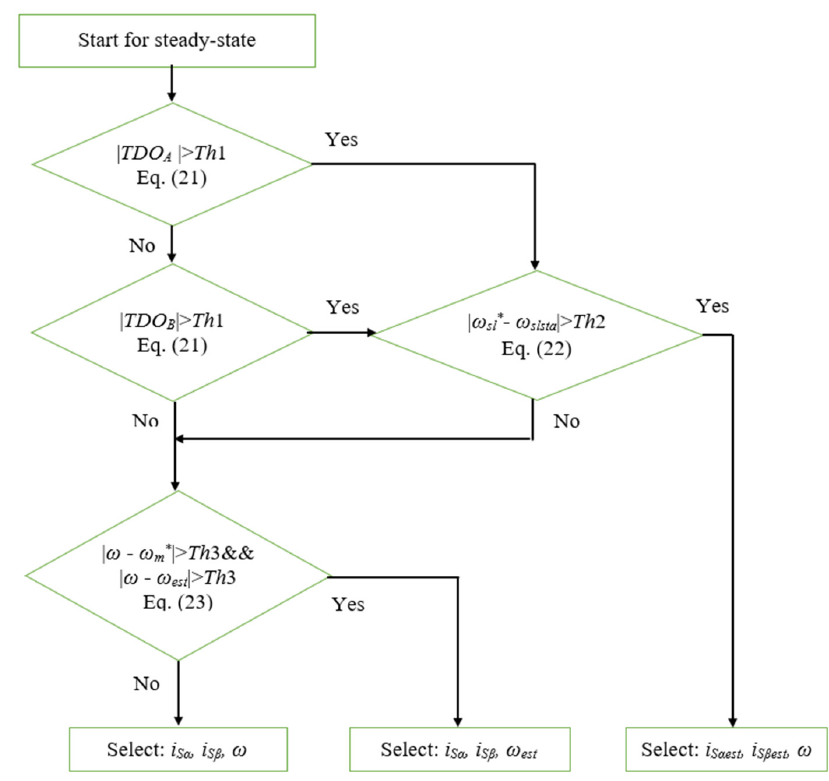
Figure 5. Block diagram of the FTC unit (the symbol * means reference values).